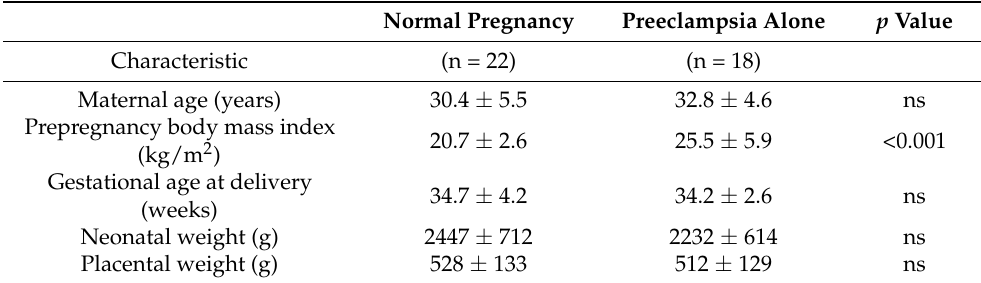
Table 1. Clinical characteristics of the study